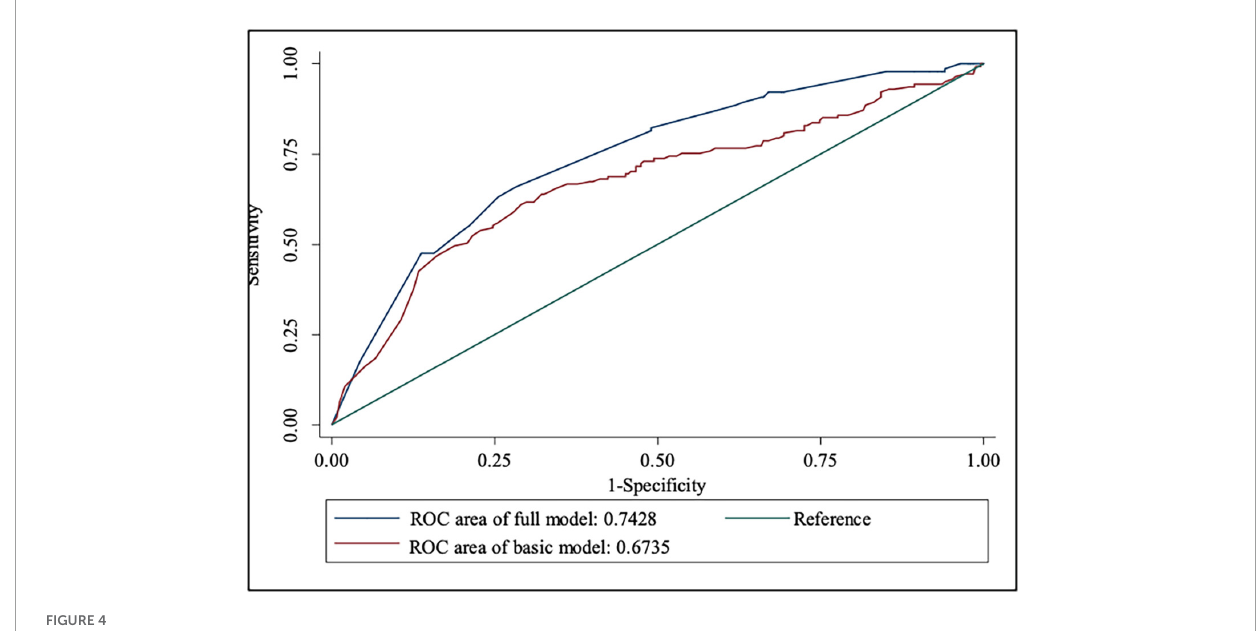
FIGURE4 ROC curve for the prediction nomograms of risk factors for NSSI.